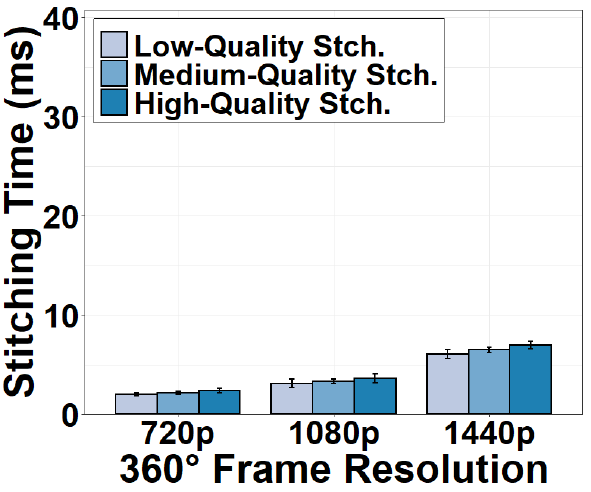
Figure 6. Frame stitching time versus stitching options.